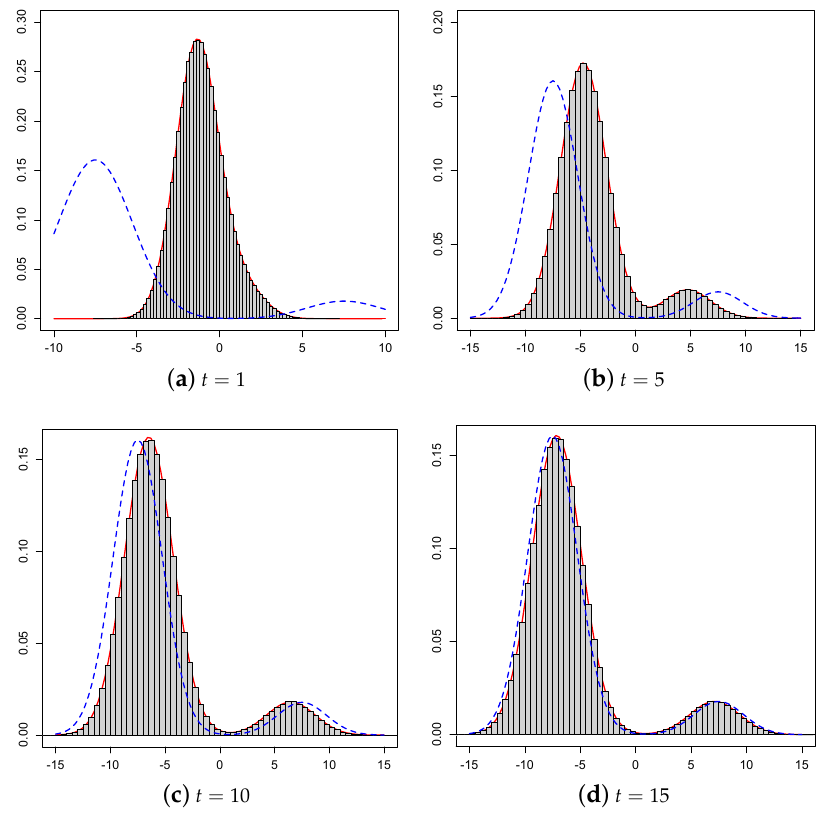
Figure 6. For the process Z ( t ) having infinitesimal moments (71), with ϑ = 0.1, α = − 0.2, β = 1.5, σ 2 = 2, the transition pdf (72) as a function of x is superimposed over a histogram obtained via Algorithm 1 for different choices of t . The dashed curves indicate the steady-state pdf given in